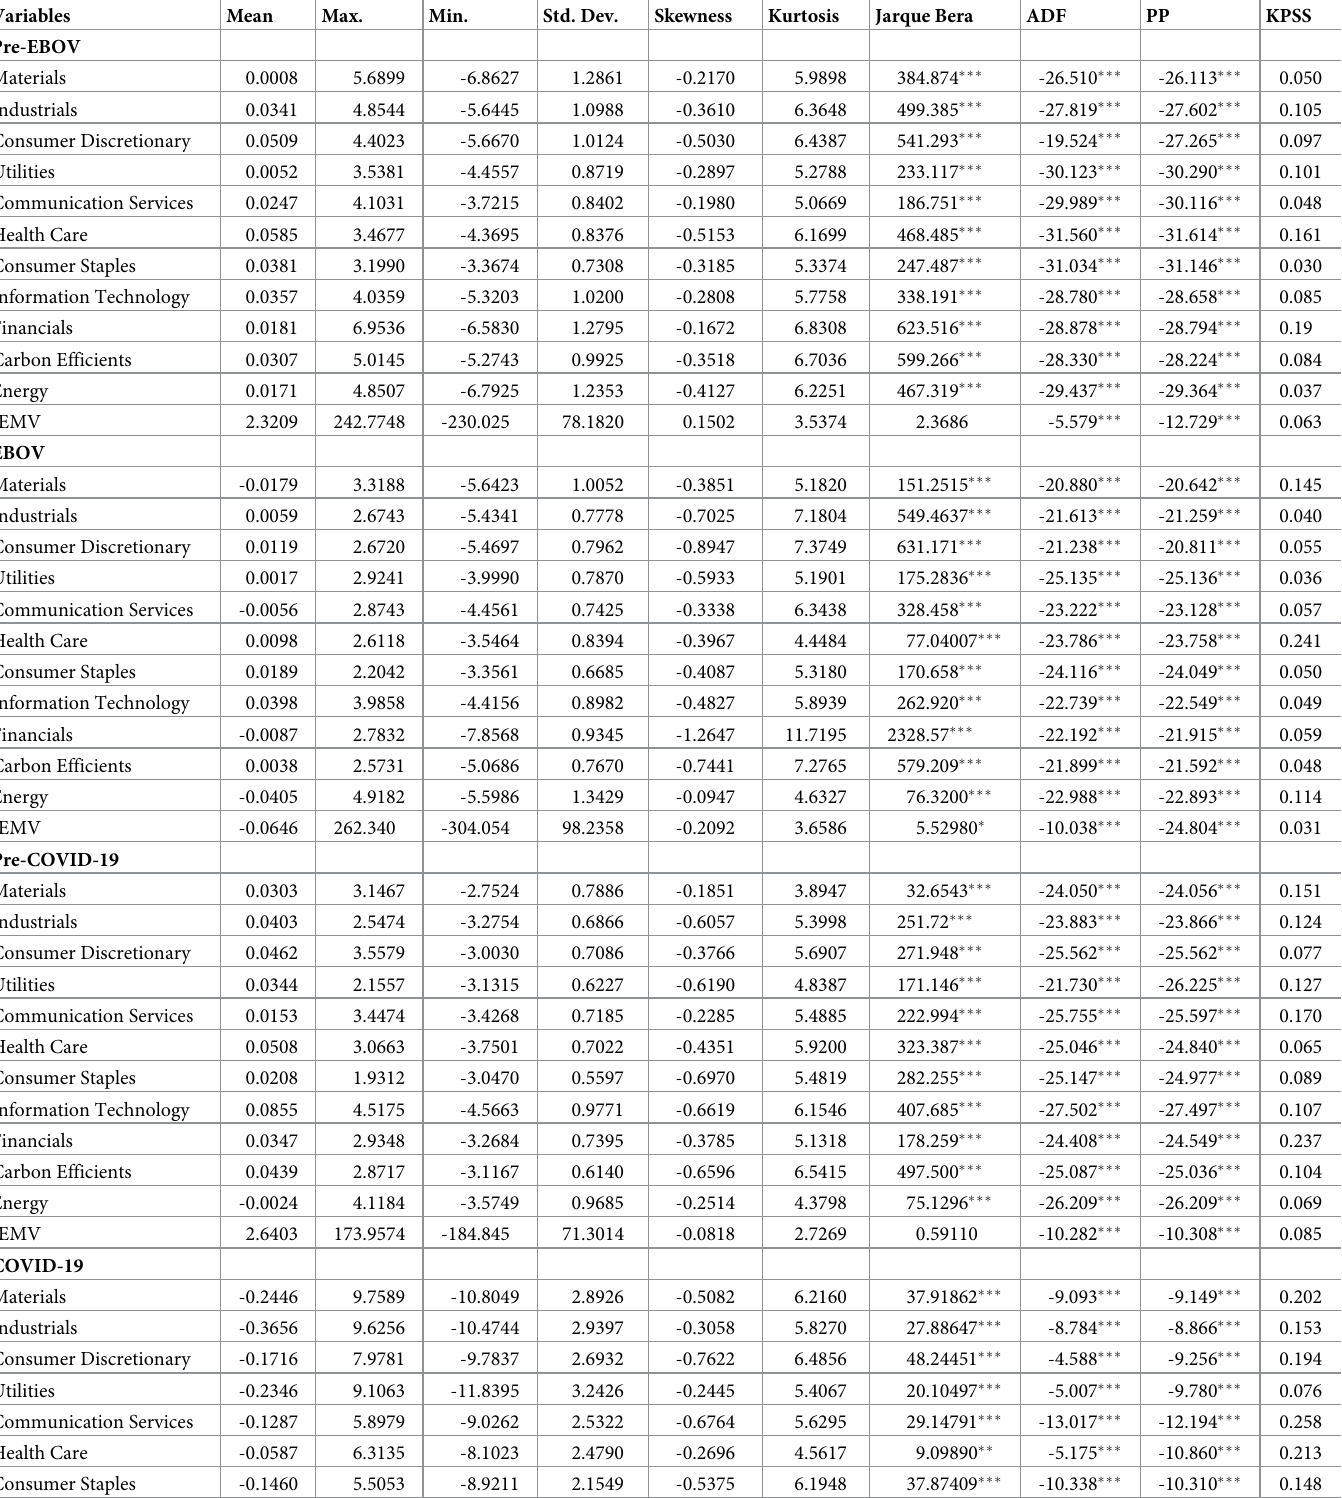
Table 2. Descriptive statistics of indices